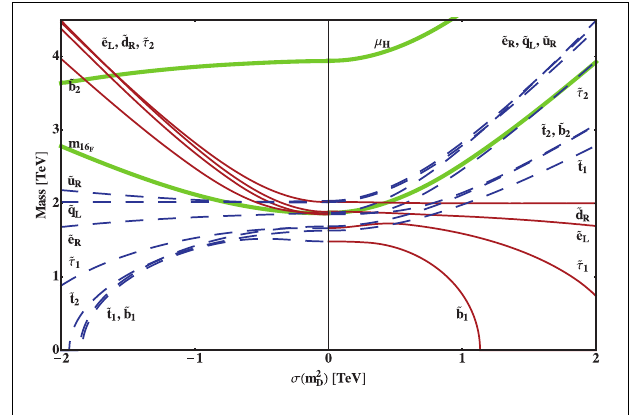
FIGURE 5 | Sparticle masses as a function of σ (cid:4)(cid:5) (cid:5) (cid:5) m 2 (cid:5) . The remaining model parameters are fixed as described in D Equation (22)